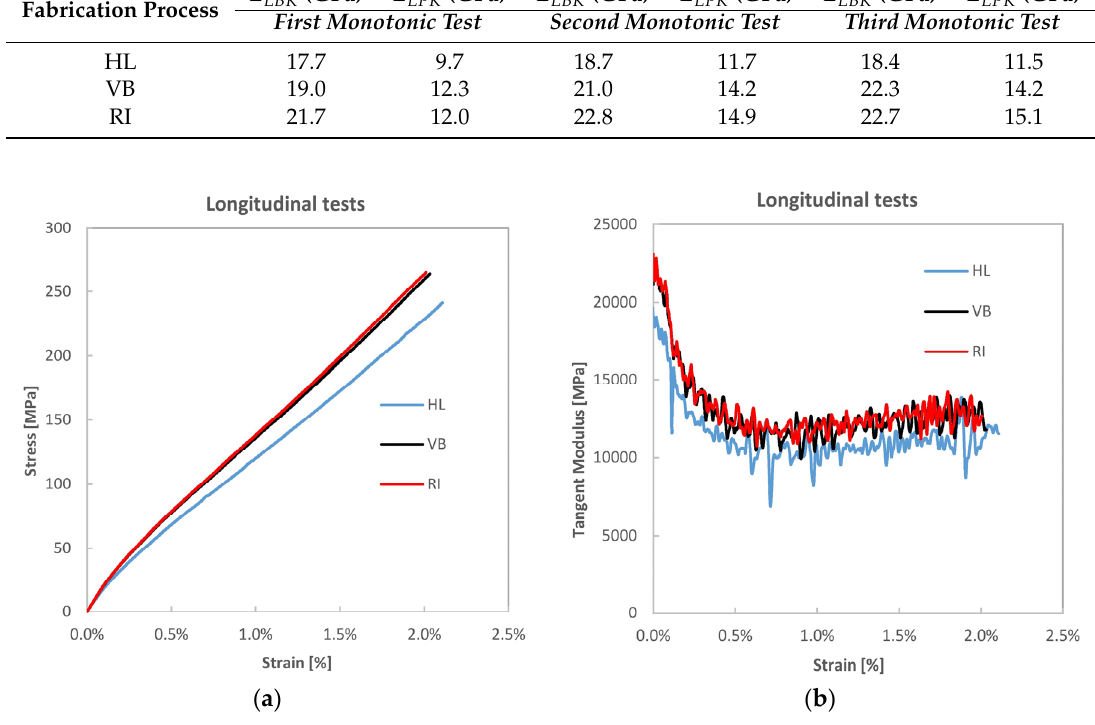
Figure 3. ( a ) Tensile stress vs. strain curves for the three manufactured batch types and ( b ) tangent modulus vs. strain.